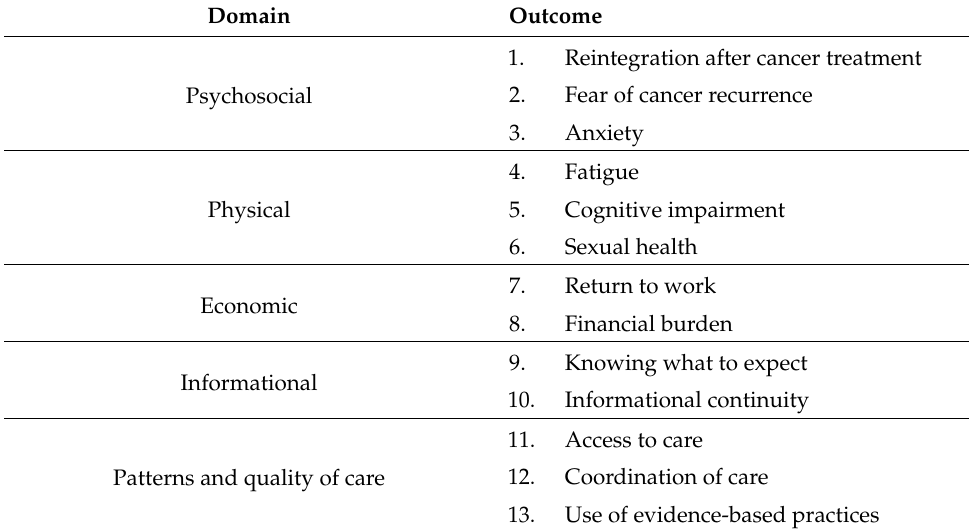
Table 2. Summary of stakeholder-relevant